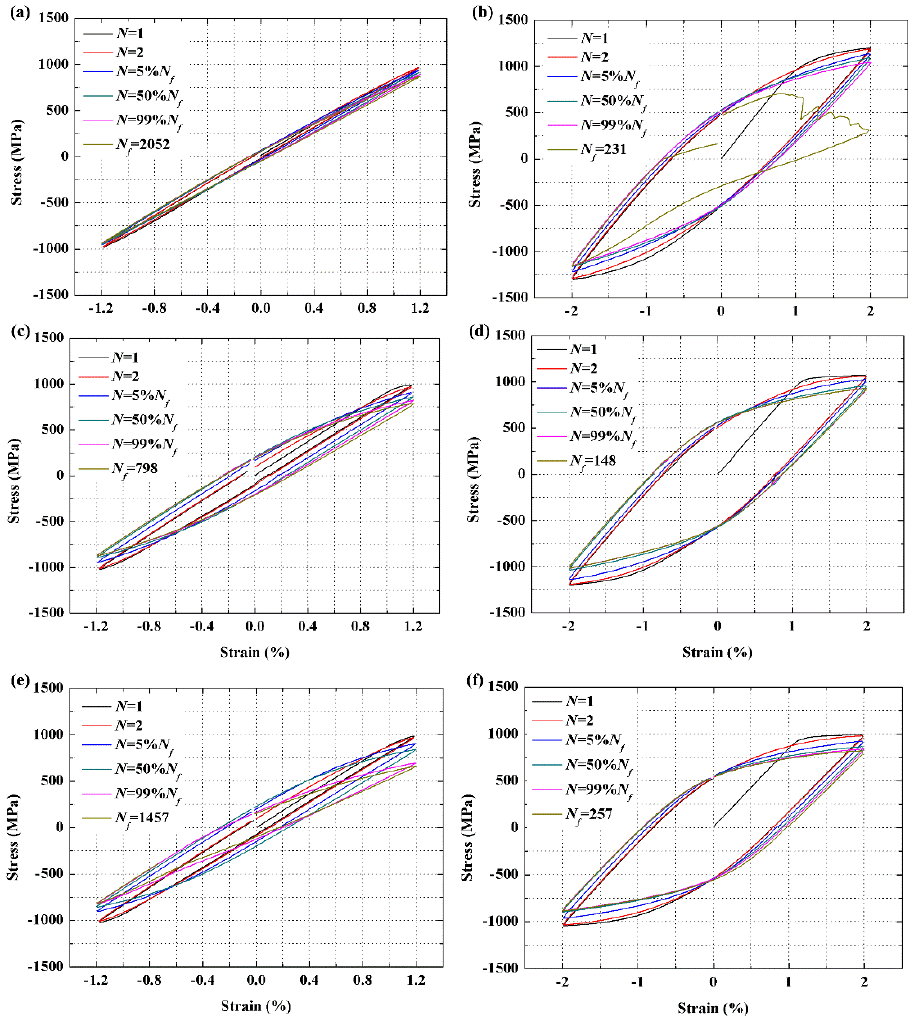
Figure 8. Stress – strain hysteresis loops for as-built samples for strain amplitude of ( a ) 1.2% and ( b ) 2%, annealed samples for strain amplitude of ( c ) 1.2% and ( d ) 2% and wrought samples for strain amplitude of ( e ) 1.2% and ( f ) 2%.